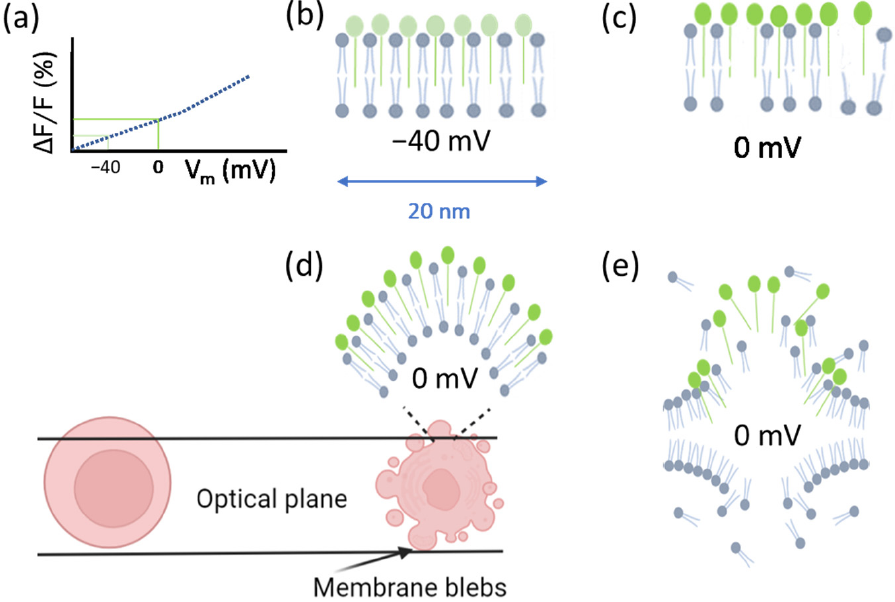
Figure 1. Dye dynamics in relation to cell viability. ( a ) Dye fluorescence intensity is proportional to membrane potential. ( b ) A cell’s resting membrane potential is negative. ( c ) Depolarization of cells due to loss of membrane integrity increases dye intensity. ( d ) Depolarization of cells also occurs during apoptosis, which increases dye intensity. Additionally, formation of apoptotic bodies increases the surface area of the membrane, thus increasing the number of dye molecules in a given optical plane. ( e ) When the cell membrane loses its integrity to the stage of membrane disintegration, the dye molecules detach. This significantly decreases the dye intensity due to the reduction in the number of dye molecules (despite a possible concomitant depolarization of the